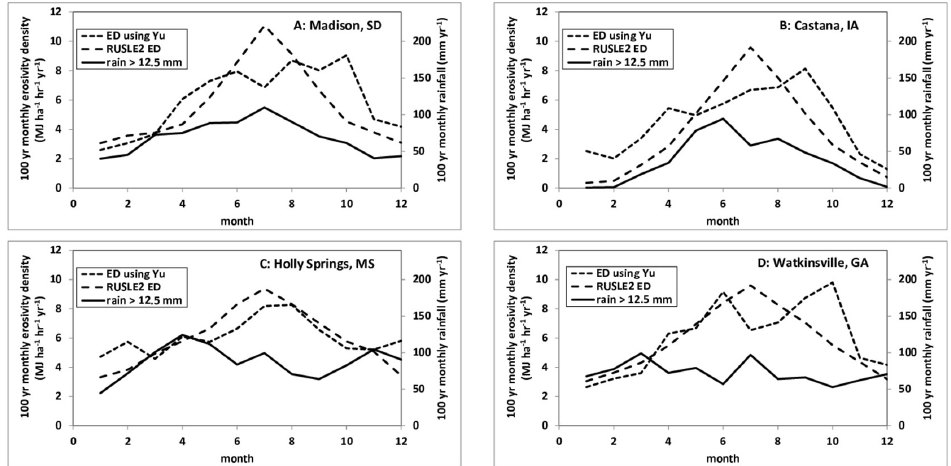
Figure 9. Long-term monthly erosivity densities for rains exceeding 12.5 mm when EI 30 values were generated using the Yu method, and RUSLE2 erosivity densities for 100 years at four locations in the USA. NB: long-term erosivity density for the month = sum EI 30 for the month over 100 years divided by the sum of rain > 12.5 mm for the month over 100 years (source: Kinnell and Yu (under review) [57]).